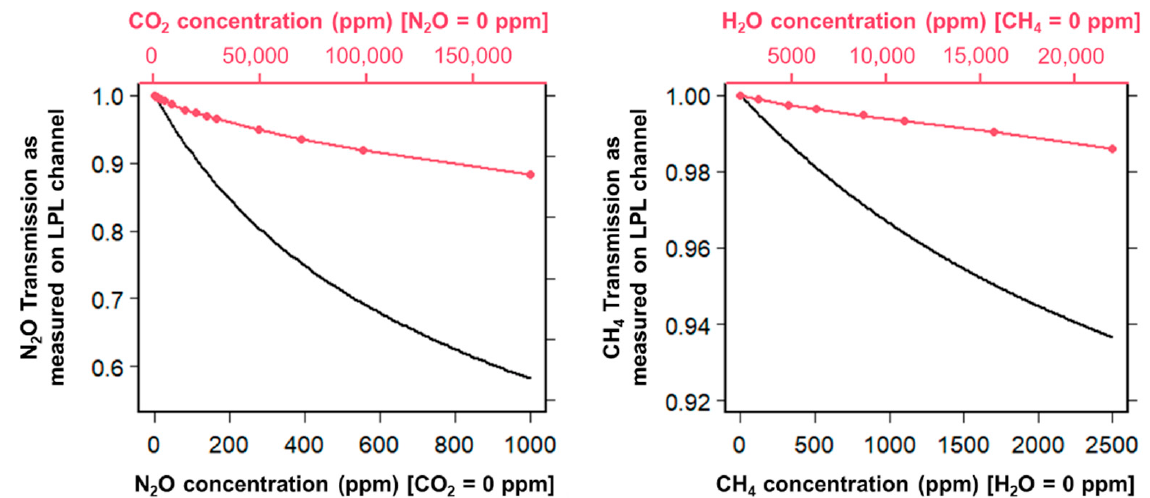
Figure 7. Left: N 2 O transmission signal as measured in function of the N 2 O concentration in the sample (with no CO 2 ) and in function of the CO 2 concentration (with no N 2 O). Right: CH 4 transmission signal as measured in function of the CH 4 concentration in the sample (with no H 2 O) and in function of the H 2 O concentration (with no CH 4 ).